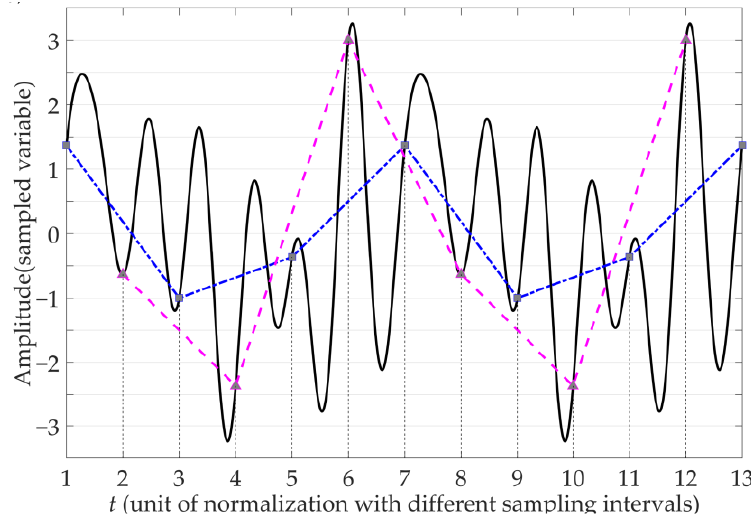
Figure 2. Procedure to obtain the permutation symbols from the sample period-6 signal as delay time τ = 2.